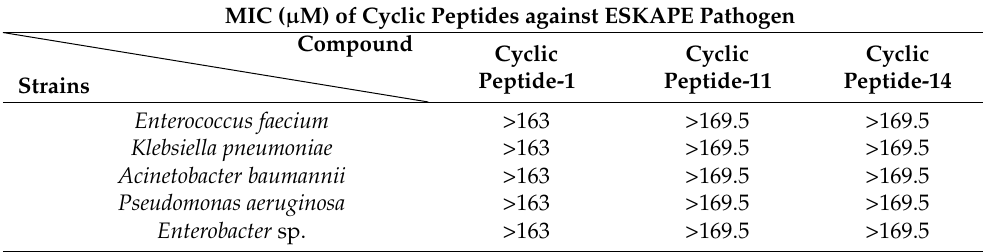
Table 2. MICs ( μ M) of cyclic peptides against the ESKAPE pathogen. MIC ( μ M) of Cyclic Peptides against ESKAPE Pathogen Compound Cyclic Table 2. MICs ( µ M) of cyclic peptides against the ESKAPE pathogen. Strains